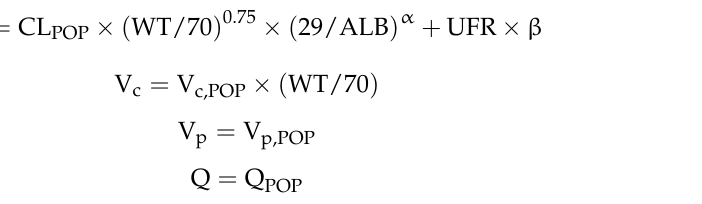
Table 2. Population estimates from the final model and bootstrap analysis results.